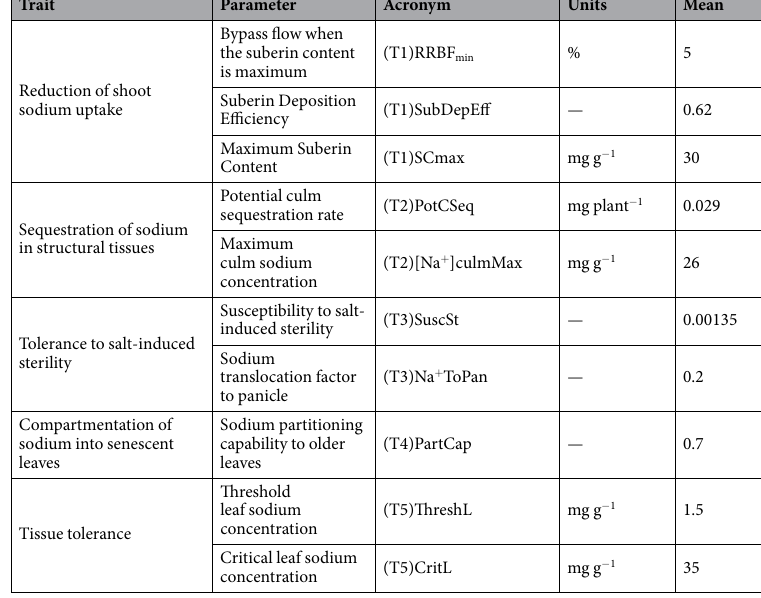
Table 1. Plant traits, corresponding model parameters and distribution means. Distributions were assumed as normal and standard deviations were set to 5% of the mean values 59